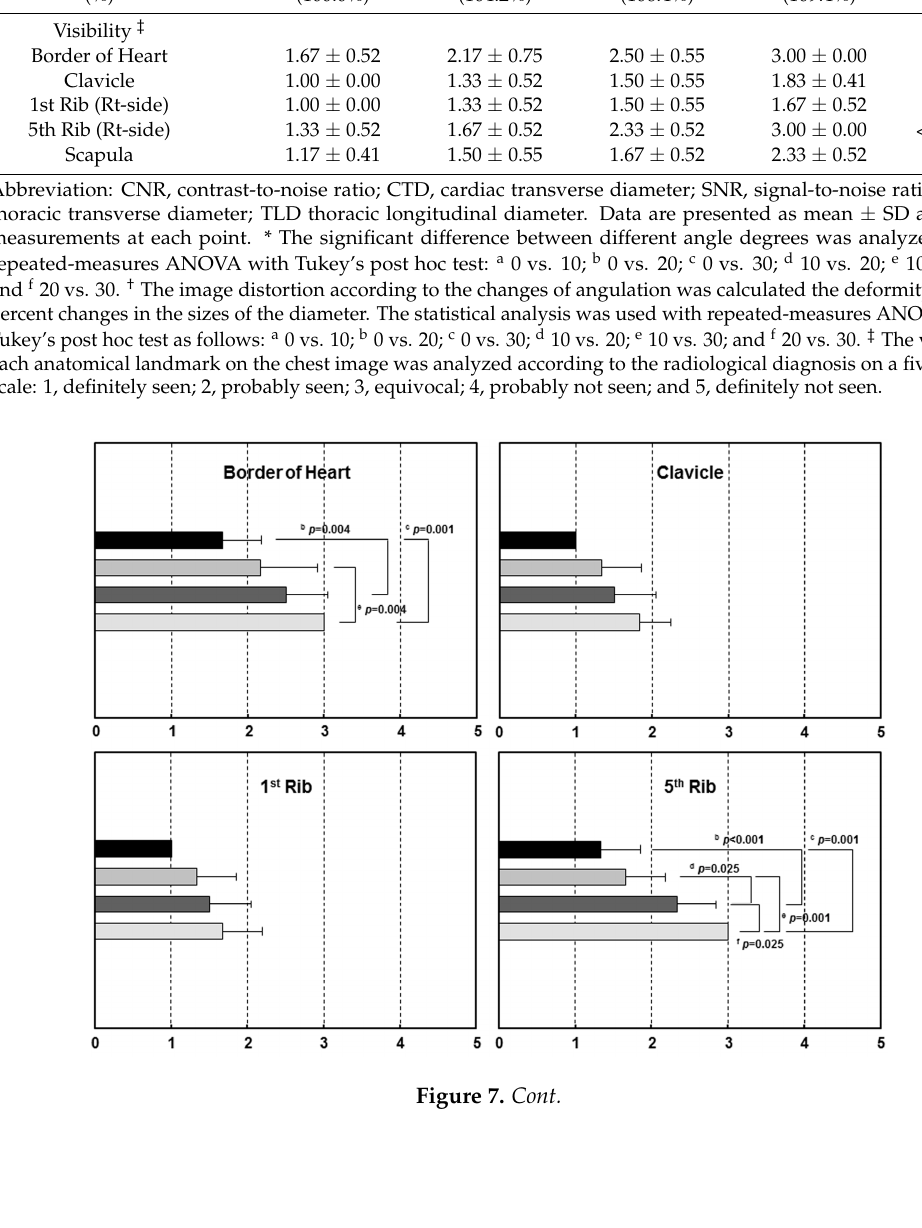
Table 2. SNR, CNR, distortion and visibility values on chest AP images according to different